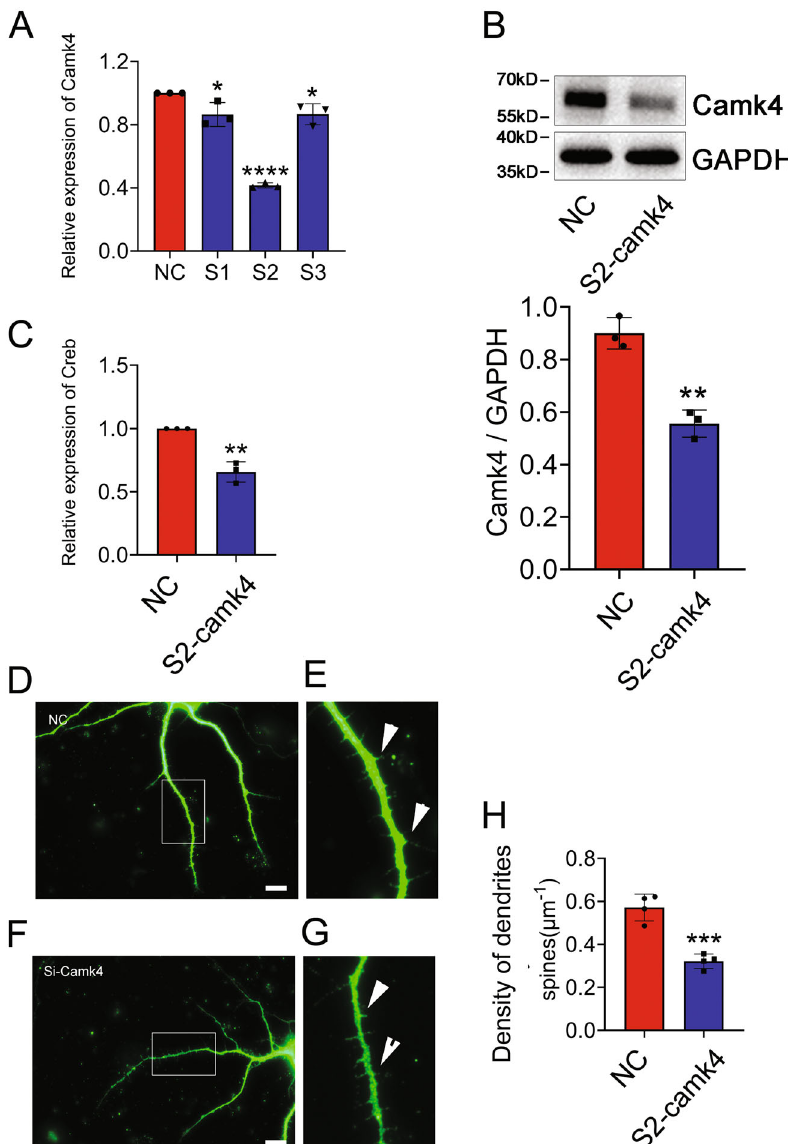
Fig. 6 Effects of CaMKIV de fi ciency on the spine density of DGC dendrites. A , B Interference ef fi ciency of three siRNA oligonucleotides for CaMKIV was measured by RT-PCR ( A ) and western blot ( B ). The siRNA2 was used for the knockdown experiments. C Transcriptional analysis of CREB following CaMKIV knockdown of DGCs for 24 h. D – G Detection of the spine density of dendrites stained by MAP2 antibody following CaMKIV knockdown of primary DGCs and kept for culture of another 5 days. Scramble was used as control. The rectangle indicates region magni fi ed. H Statistic analysis of spine density in quadruplicates each 15 fi elds. Six pups of each group were used to isolate DGCs. Arrowheads indicate spines. Scale bars, 10 μ